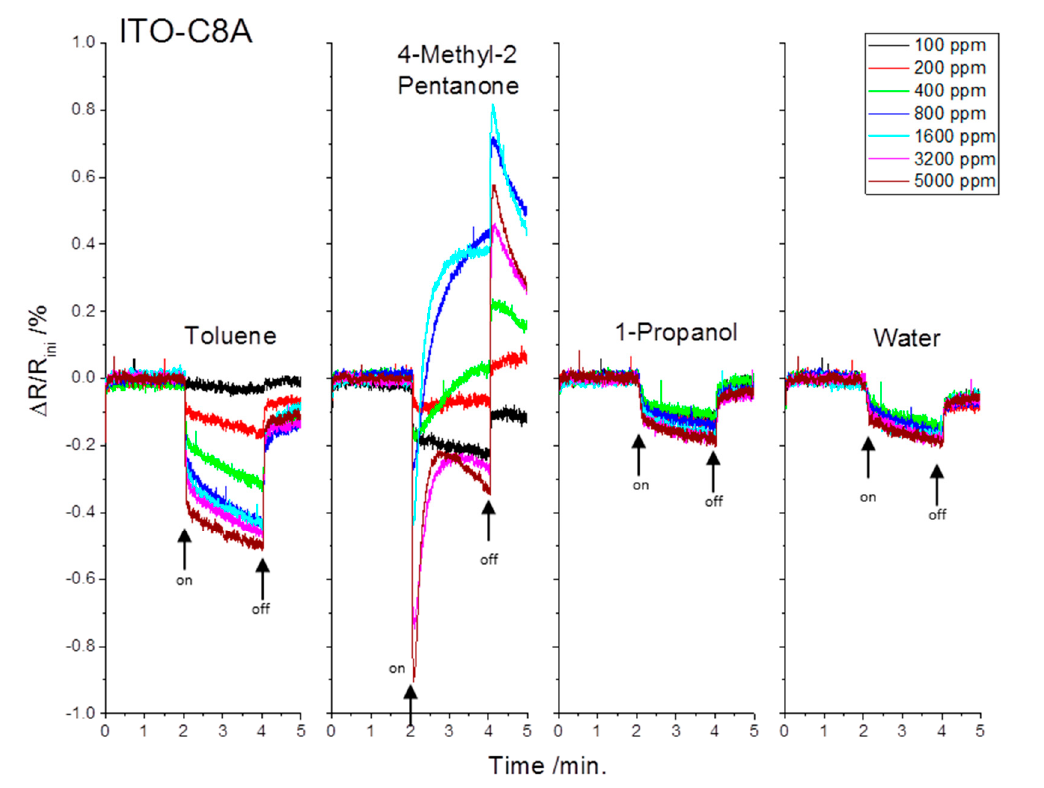
Figure 3. Chemiresistive sensing properties of ITO nanoparticles interlinked with 1,8-Diaminooctane towards the indicated concentrations of the indicated vapors. The arrows mark the delivery of the VOC to the